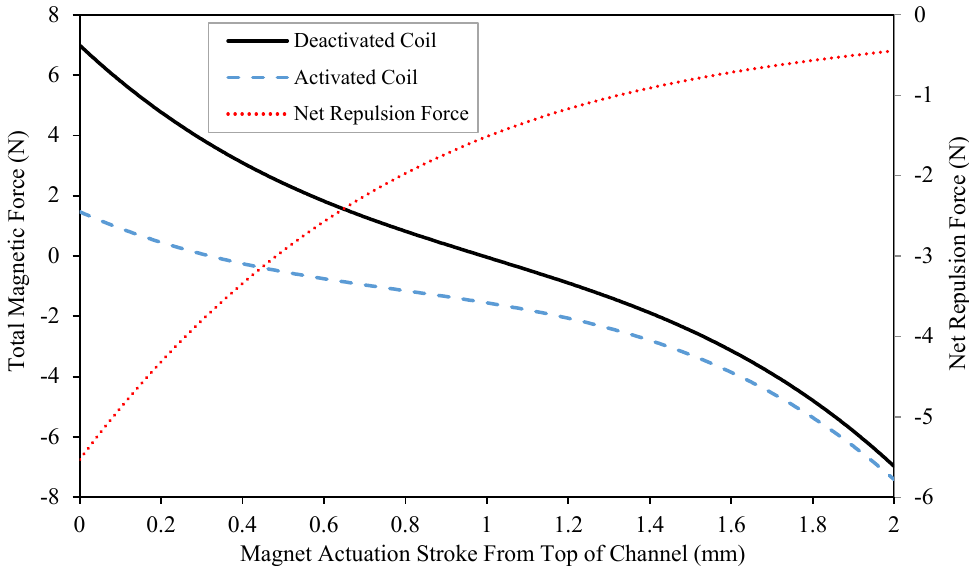
Figure 3. Total magnetic force (when the coil was deactivated and activated) and net repulsion force on the magnet along its stroke from the top to the lower end of the channel.